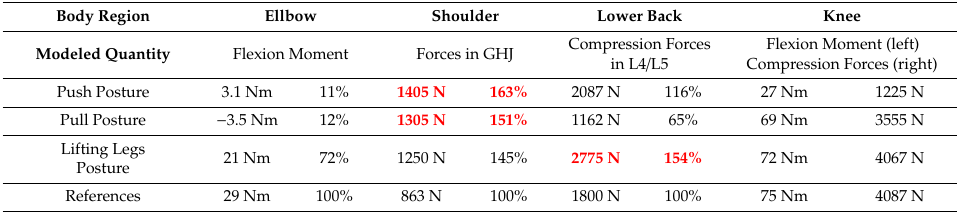
Table 2. Maximal joint reactions overall body